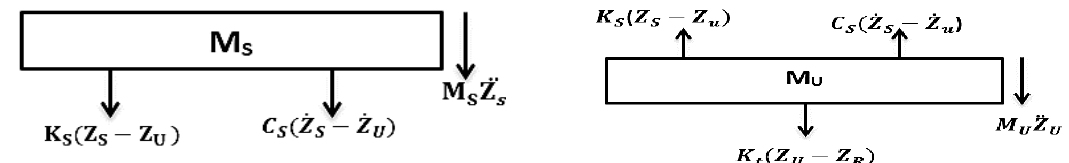
Figure 1. Quarter car model